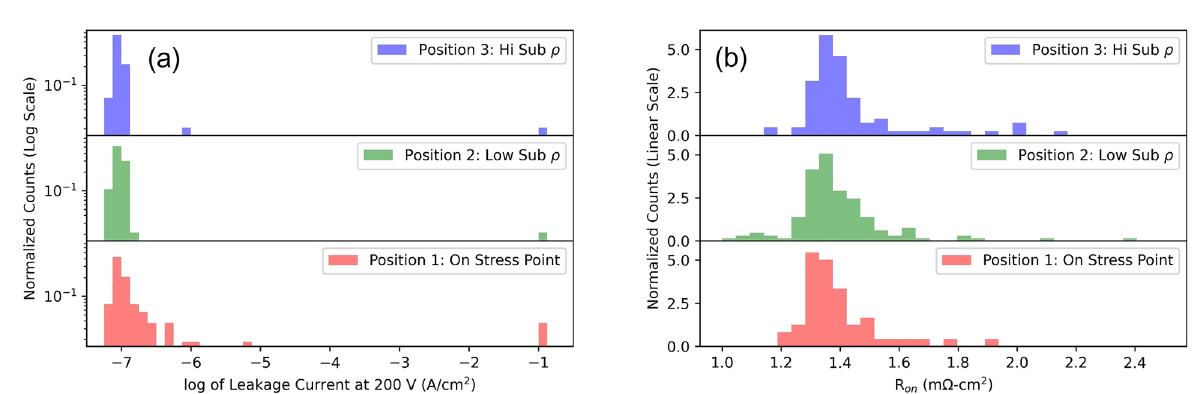
Figure 5. A histogram distribution of reverse leakage currents ( a ) and on resistance ( b ). The data is separated based on the 3 regions defined in Fig. 3a. Catostrophic failures were set at the saturation current of the instrument (100 mA) in part ( a